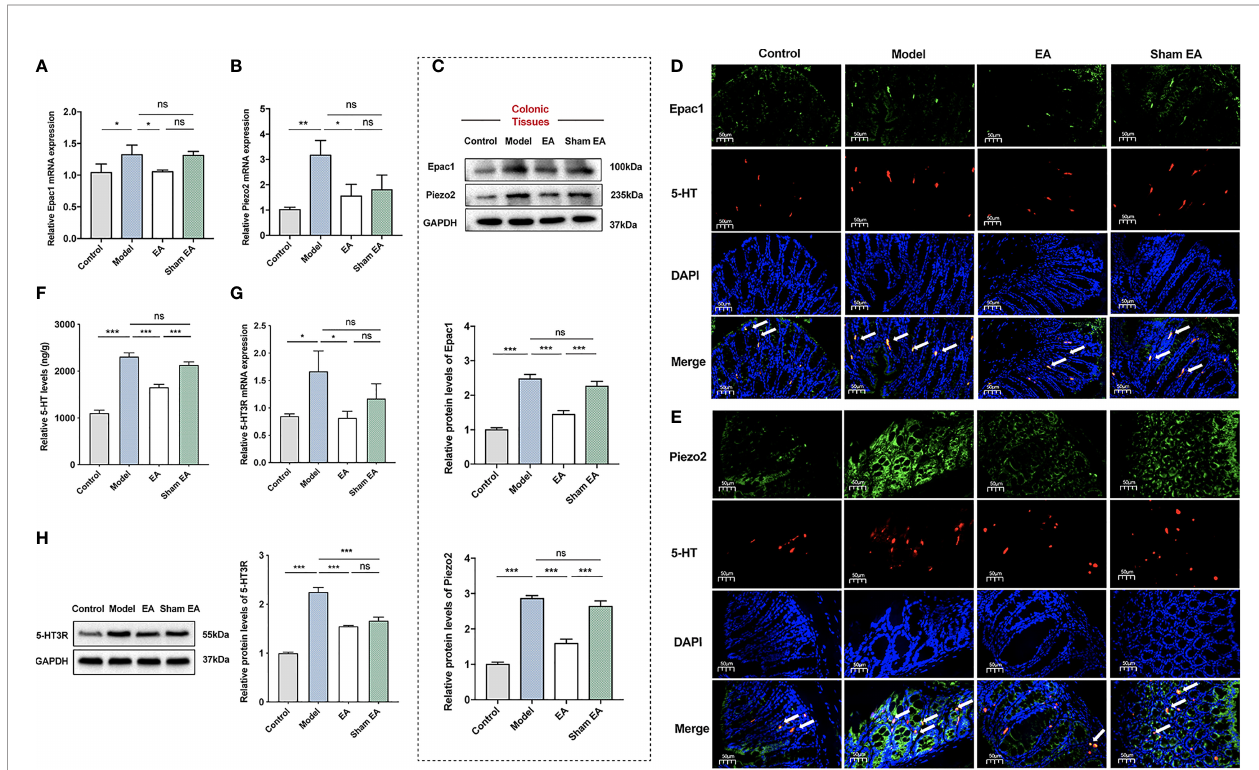
FIGURE 3 | Effect of EA on the expression of Epac1, Piezo2, 5-HT, and 5-HT 3 R in the colon of PI-IBS model mice. (A) Relative colonic Epac1 mRNA expression (n=5). (B) Relative colonic Piezo2 mRNA expression (n=5). (C) Representative Western blot analyses of Epac1 and Piezo2 staining and relative protein levels in the colonic tissues (n=5). (D, E) Representative images showing Epac1/Piezo2 (green), 5-HT (red), and DAPI (blue) fl uorescence in different groups (×400, scale bar=50 m m). The arrow head in the merged image indicate co-expression (n=3). (F) ELISA analysis of 5-HT in colonic tissues (n=6). (G) Relative colonic 5-HT expression (n=5). (H) Representative Western blot analyses of 5-HT 3 R staining and relative protein levels in the colonic tissues (n=3). Data are presented as mean ± SEM; (A-C, F-H) : One-way ANOVA with LSD multiple comparisons test; * P < 0.05, ** P < 0.01, *** P < 0.001, ns P